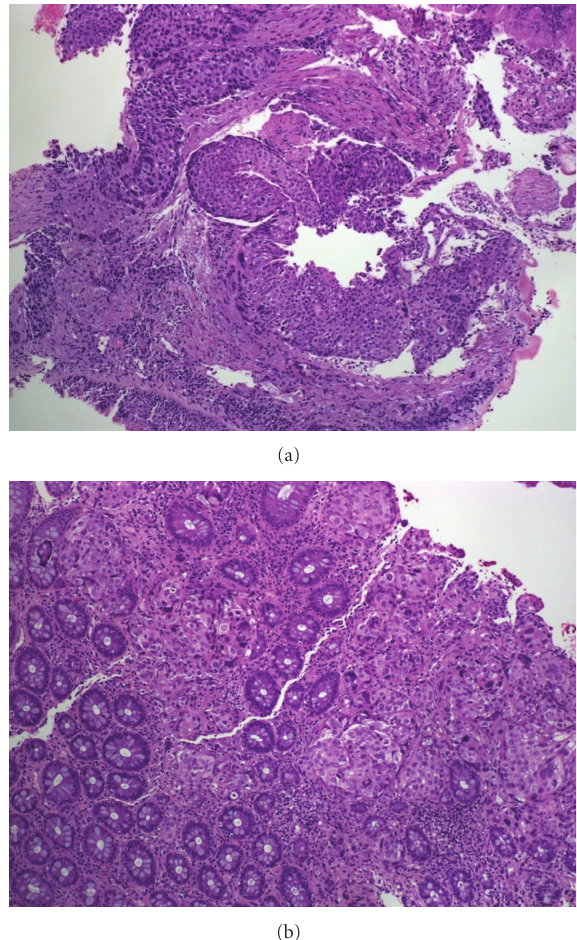
Figure 3: Microscopic findings: (a) (hematoxylin eosin (HE) 10x) primary squamous cell carcinoma. (b) (HE 10x) keratin deposits and digestive glands in rectal